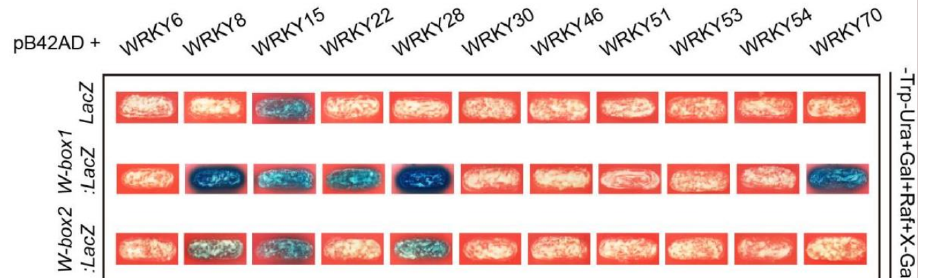
Figure 10. Identification of defense and senescence related WRKYs binding to the promoter of AtWAKL10 . Yeast one-hybrid assays indicated that most WRKYs bound to the promoter region of AtWAKL10 through the W-box motif nearby the start codon. Various WRKY transcription factors involved in defense response or leaf senescence were cloned into the pB42AD vector. Two fragments containing the W-box motif as indicated were inserted into the pLacZi vector, respectively. EGY48 yeast stains carrying two vectors were grown on SD/-Trp-Ura+Gal+Raf+X-Gal medium. Colonies in blue color indicate the positive interaction between protein and DNA